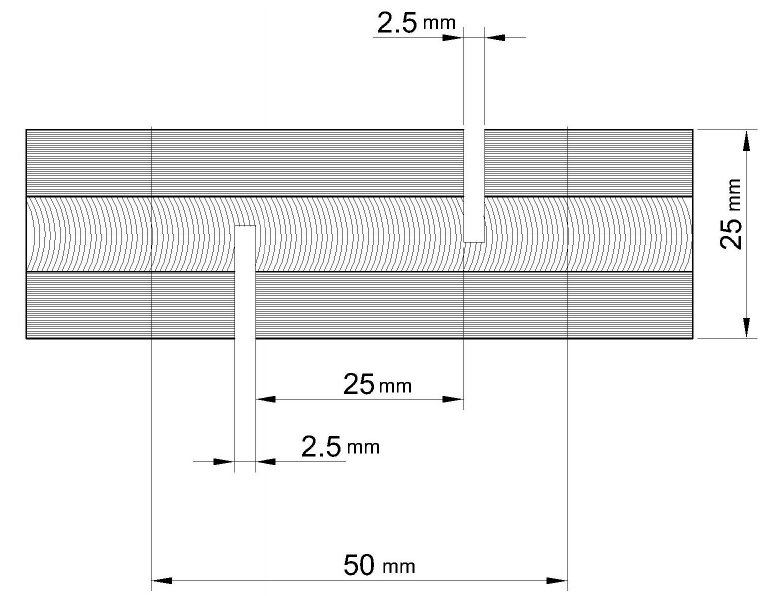
Figure 3. Linear diagram of shear-strength test specimen according to European standard specifications EN 314-1: 2004.